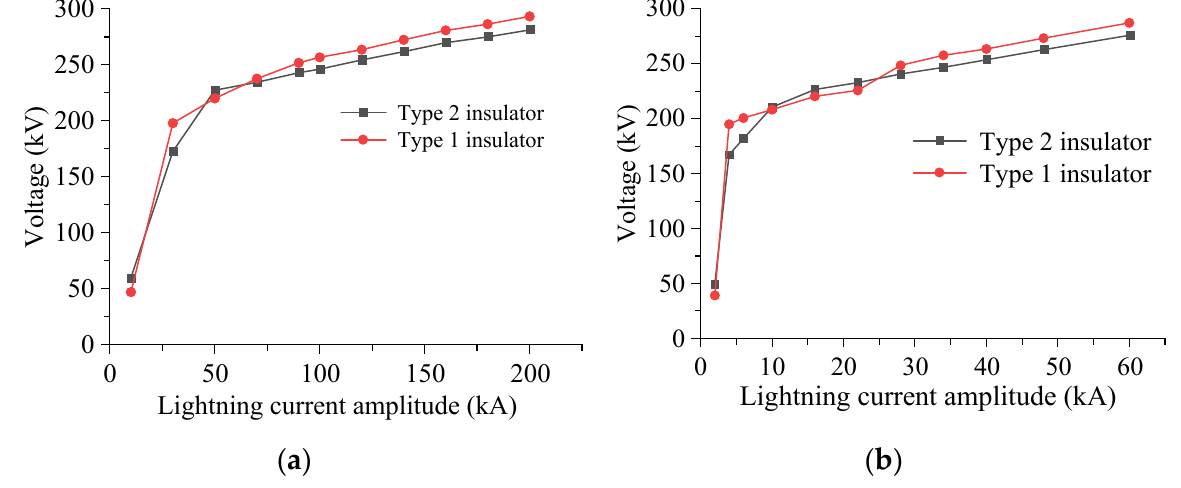
Figure 10. Influence of lightning current amplitude on voltage: ( a ) overvoltage of back flashover; ( b ) overvoltage of direct flashover.